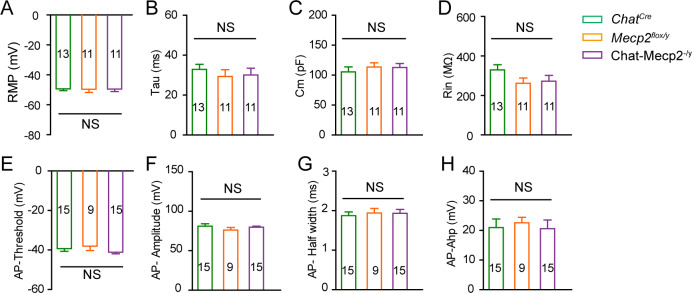
Chat-Mecp2-/y Mice Exhibited No Statistical Difference in Intrinsic Properties in NAc Cholinergic Interneurons, Related to Figure 3.(A–D) Quantitative analysis of resting membrane potential (RMP), membrane time constant (Tau), input resistance (Rin), and membrane capacitance (Cm) of cholinergic interneurons from NAc slices. P-values were calculated by one-way analysis of variance (ANOVA) with Bonferroni’s multiple comparisons test. F (2, 32)=0.005866, p=0.9942 for RMP. F (2, 32)=0.3762, p=0.6894 for Tau. F (2, 32)=0.3748, p=0.6904 for Cm. F (2, 32)=1.809, p=0.1801 for Rin. n = 13 neurons from four mice (ChatCre), 11 neurons from three mice (Mecp2flox/y), 11 neurons from three mice (Chat-Mecp2-/y). (E–H) Quantitative analysis of threshold, amplitude, half width, and after-hyperpolarization potential (ahp) for a single spike of cholinergic interneurons from NAc slices. P-values were calculated by one-way ANOVA with Bonferroni’s multiple comparisons test. F (2, 36)=1.222, p=0.3066 for threshold. F (2, 36)=0.7935, p=0.4600 for amplitude. F (2, 36)=0.1402, p=0.8697 for half width. F (2, 36)=0.1137, p=0.8929 for ahp. n = 15 neurons from four mice (ChatCre), 9 neurons from three mice (Mecp2flox/y), 15 neurons from five mice (Chat-Mecp2-/y). Data are means ± SEM. NS means no significance.